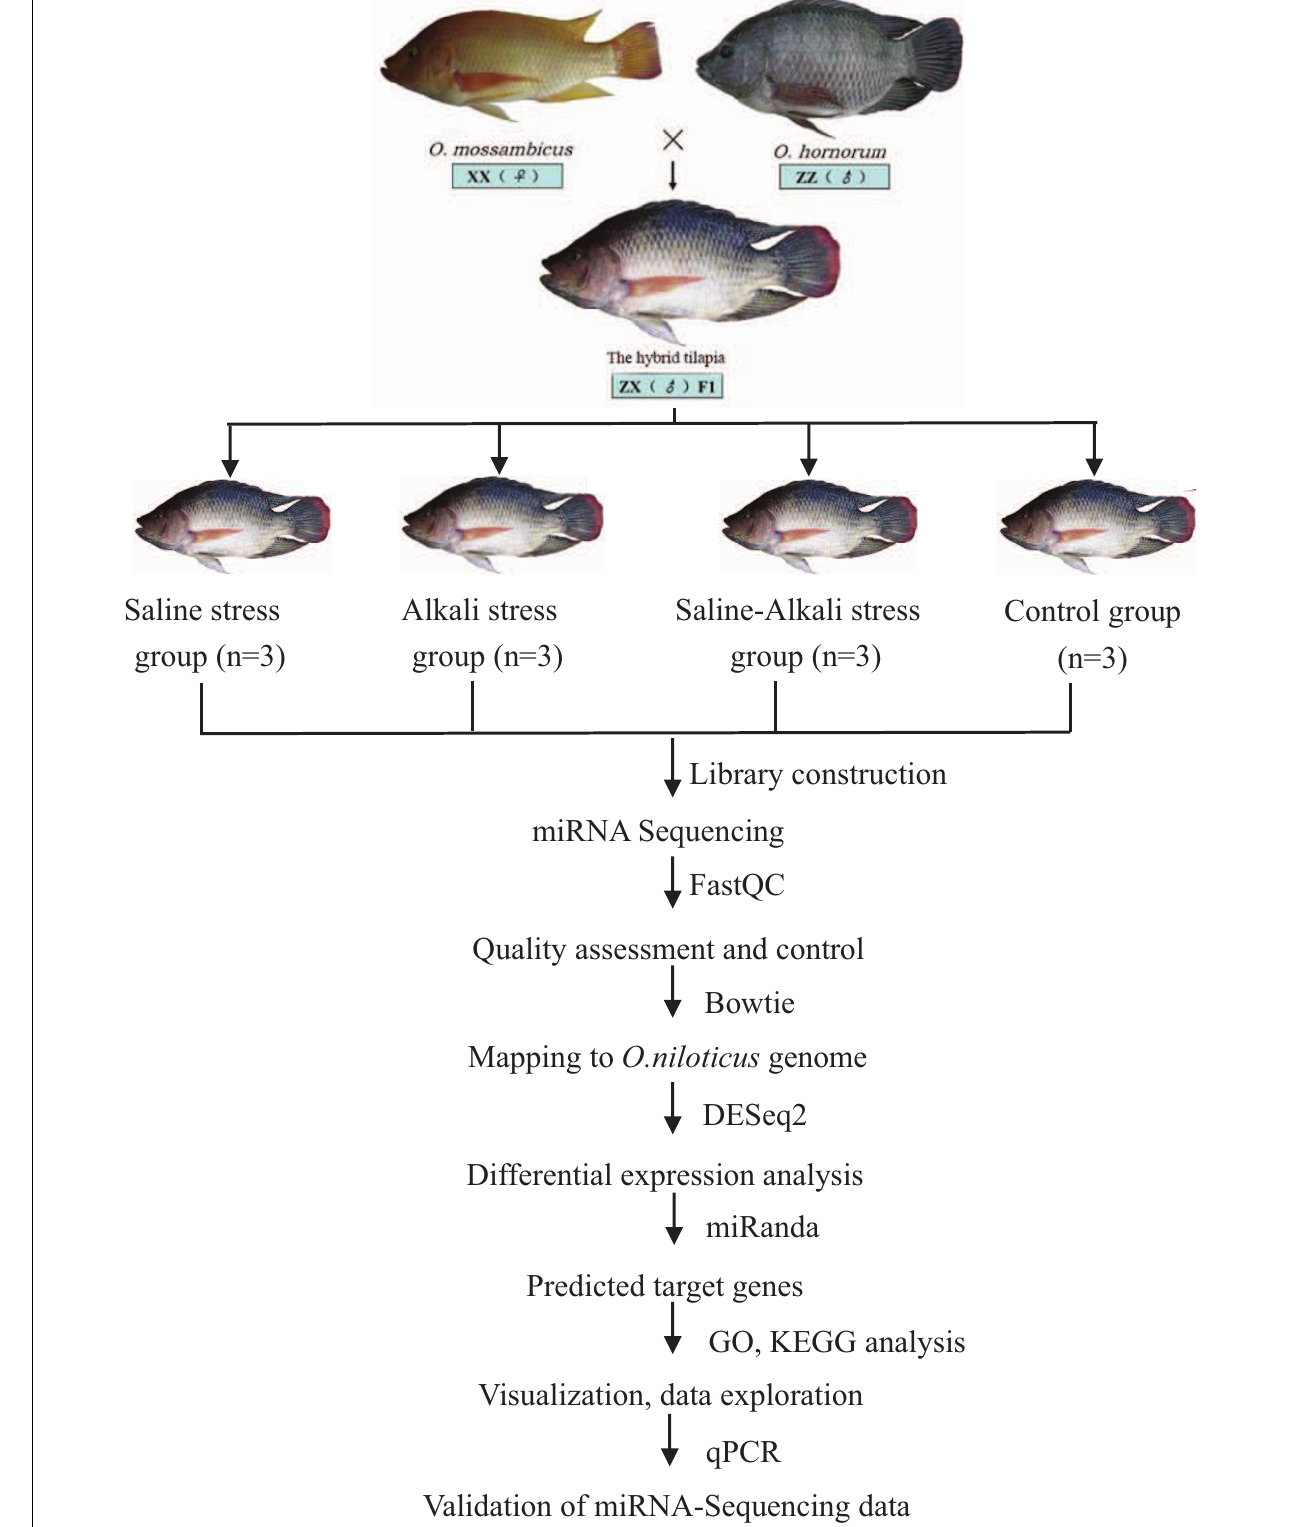
Frontiers in Genetics |